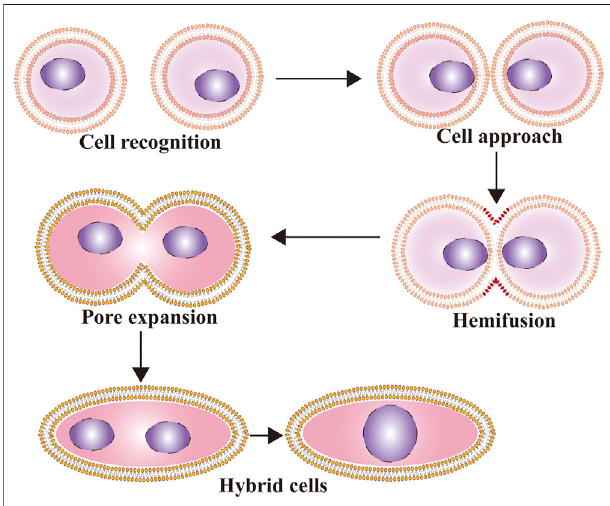
FIGURE 1 | The process of cell fusion. The whole fusion process can be divided into three steps: preparation for fusion, membrane approach under the action of fusogens, and constitution of new cells with lipidic